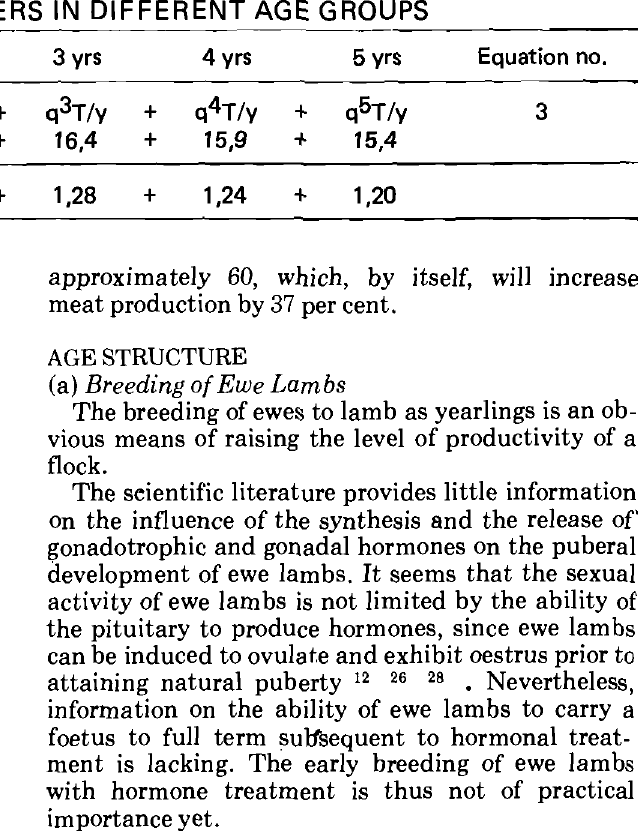
Table 2: DISTRIBUTION OF WETHERS IN DIFFERENT AGE GROUPS